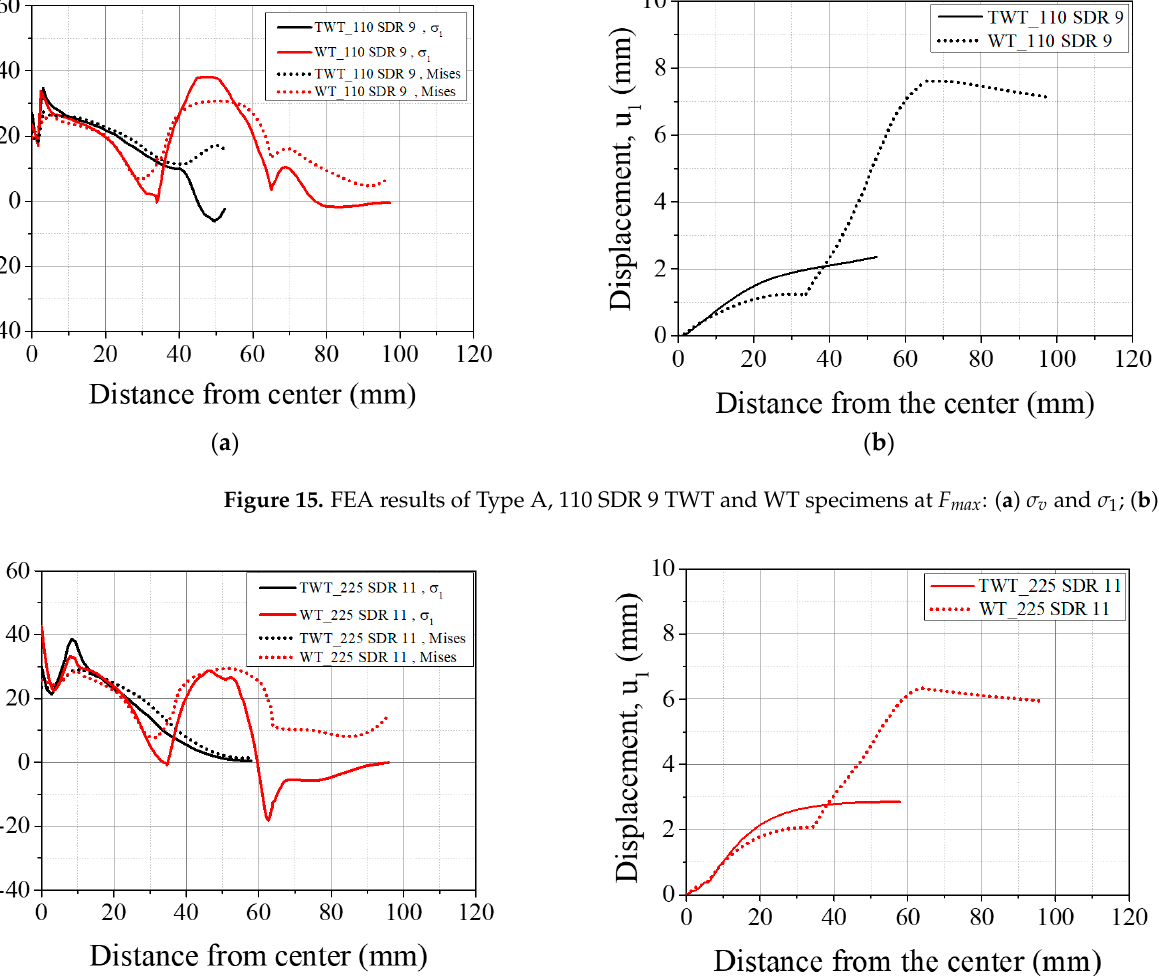
Figure 16. FEA results of Type A, 225 SDR 11 TWT and WT specimens at F max : ( a ) σ v and σ 1 ; ( b ) u 1 .